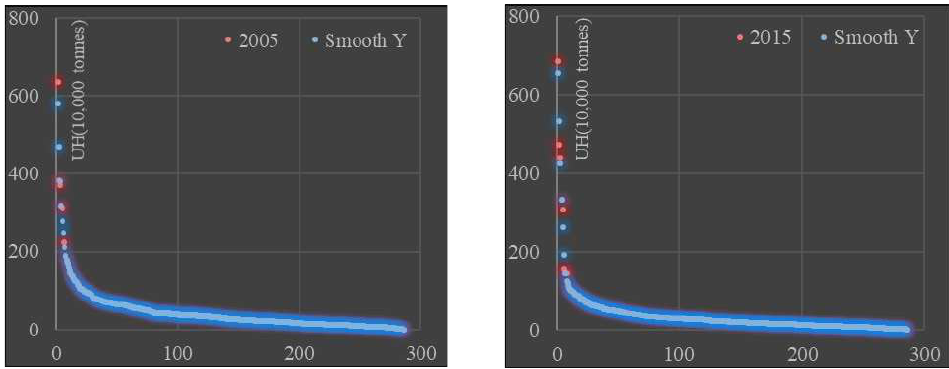
Figure 2. Urban household carbon emissions rank-size distribution.